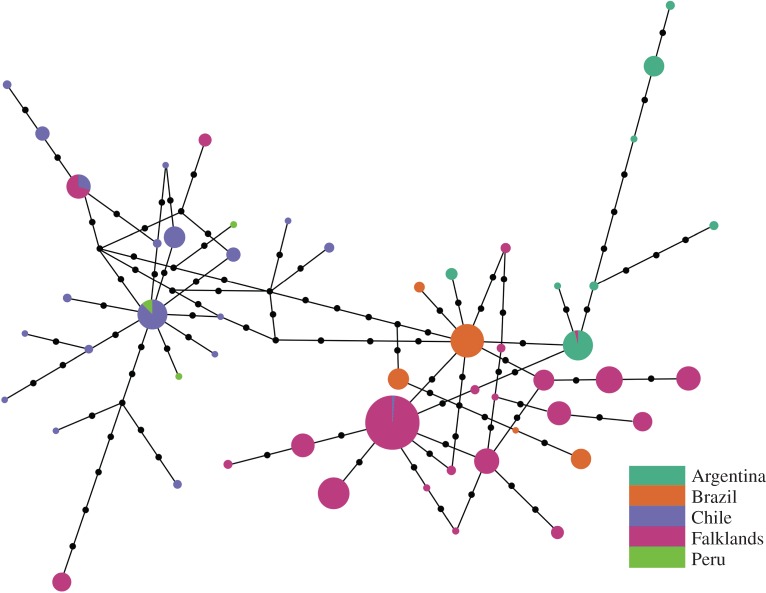
Median joining network showing the phylogenetic relationships among 53 mitochondrial haplotypes obtained from the Falkland Islands, Argentina, Brazil, Chile and Peru. Each line joining two circles corresponds to a single nucleotide substitution, with coloured circles representing observed haplotypes and black circles representing hypothetical haplotypes that were not observed in the sample. Circle size is proportional to the relative frequency of each of the observed haplotypes.